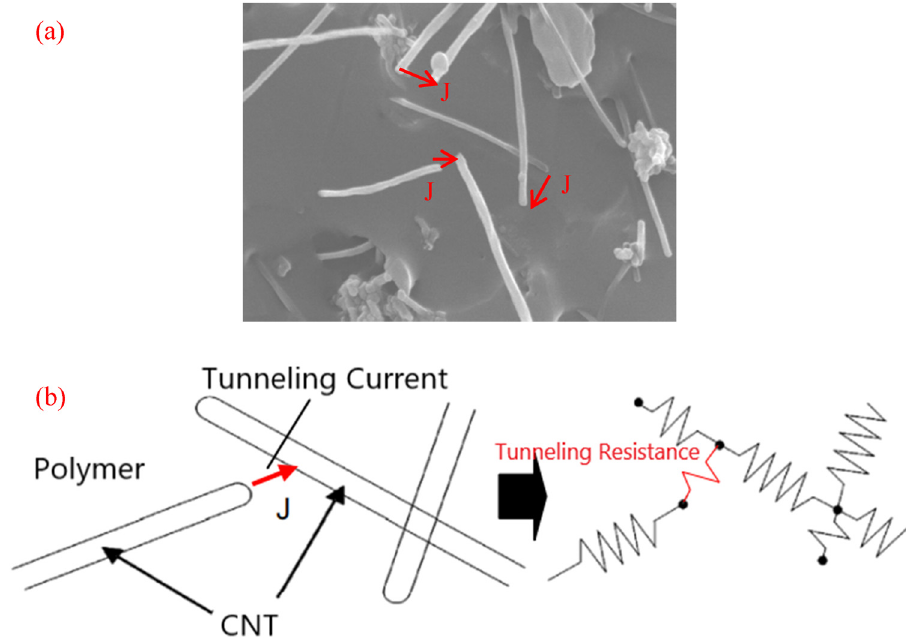
Figure 12: Schematic diagram of CNTCS tunneling e ff ect ( J stands for tunneling current ) : ( a ) SEM image of possible CNT tunneling and ( b ) tunneling model diagram [ 143 ]